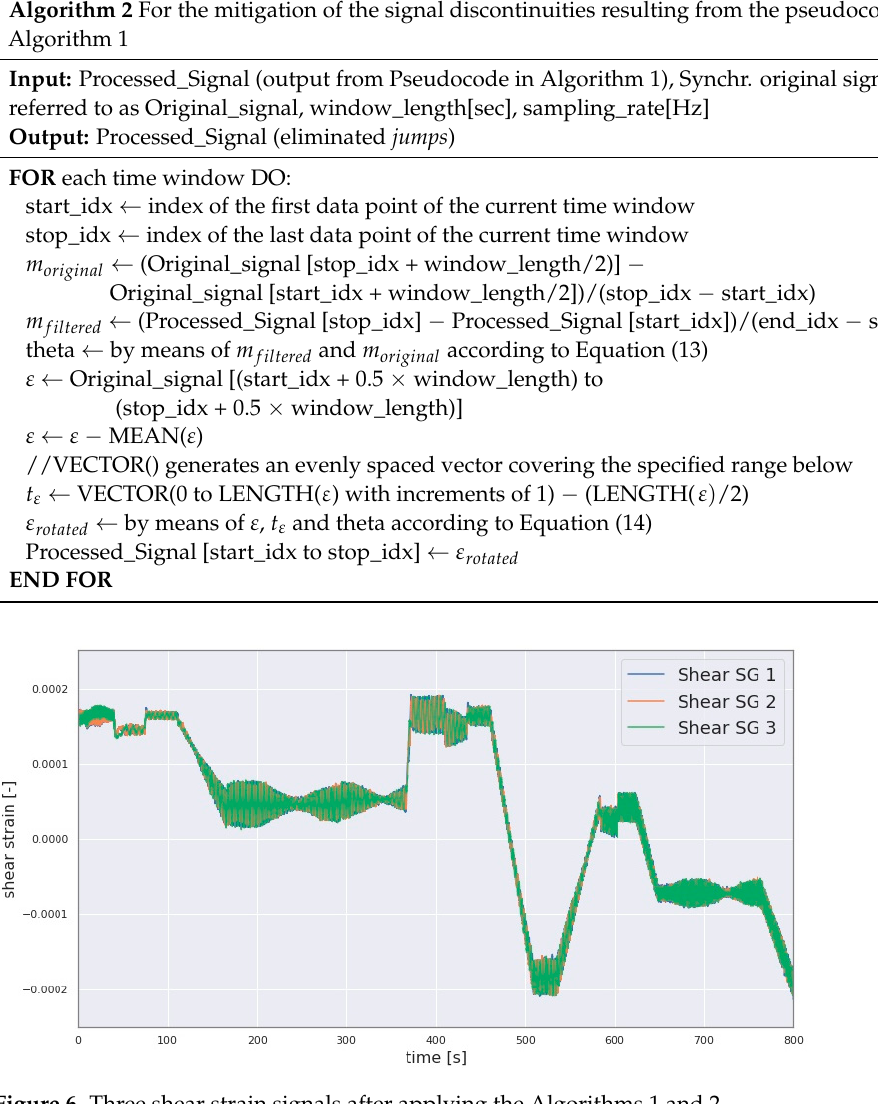
Figure 6. Three shear strain signals after applying the Algorithms 1 and 2.